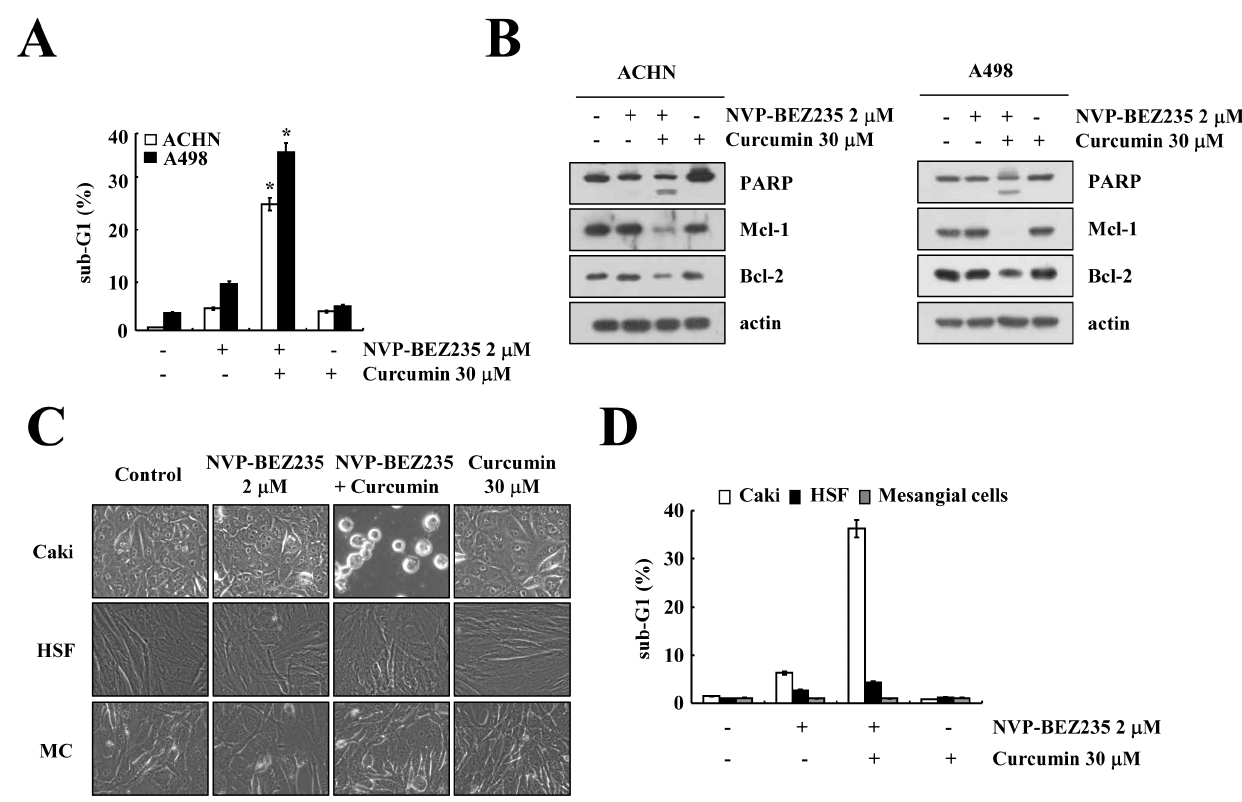
Figure 6. Effect of combined treatment with NVP-BEZ235 (NVP) and curcumin on apoptosis in other renal cancer cells and normal cells. Other renal cancer cells (ACHN and A498) and normal cells (HSFs and MCs) were treated with 2 m M NVP-BEZ235 plus 30 m M curcumin for 48 h. The sub-G1 fraction was measured by flow cytometry (A and D). Equal amounts of cell lysate (40 m g) were subjected to electrophoresis and analyzed by western blotting for PARP, Mcl-1, and Bcl-2 and actin as a control for protein loading (B). Cell morphology was detected by interference light microscopy (C). * p , 0.001 compared to NVP-BEZ235 alone and curcumin alone. The values in A and D represent the mean 6 SD from three independent samples. The data represent three independent